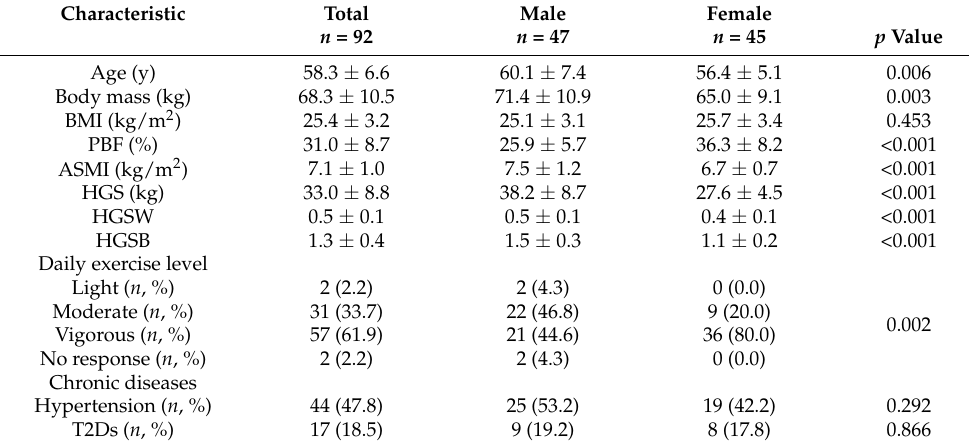
Table 1. General